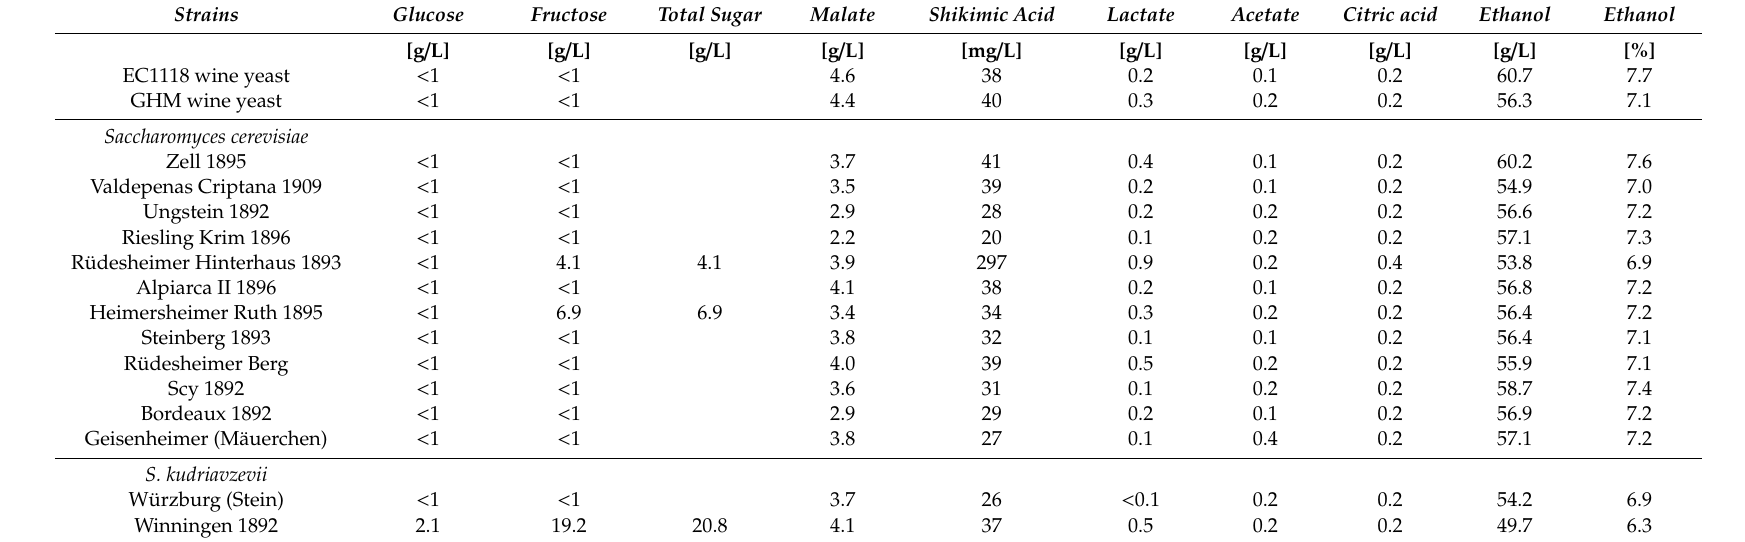
Table 2. HPLC analyses of residual sugars, organic acids, and total alcohol of Saccharomyces wine